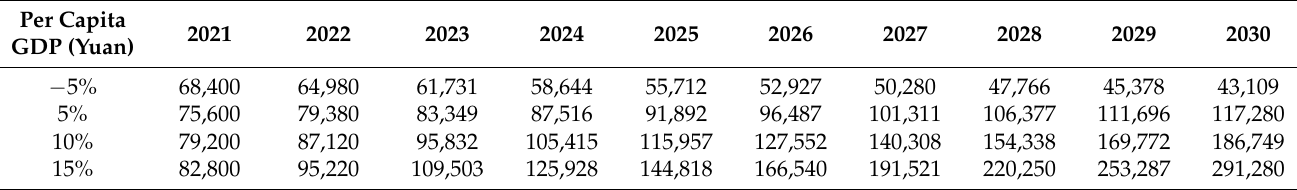
Table 5. Per capita GDP at different growth